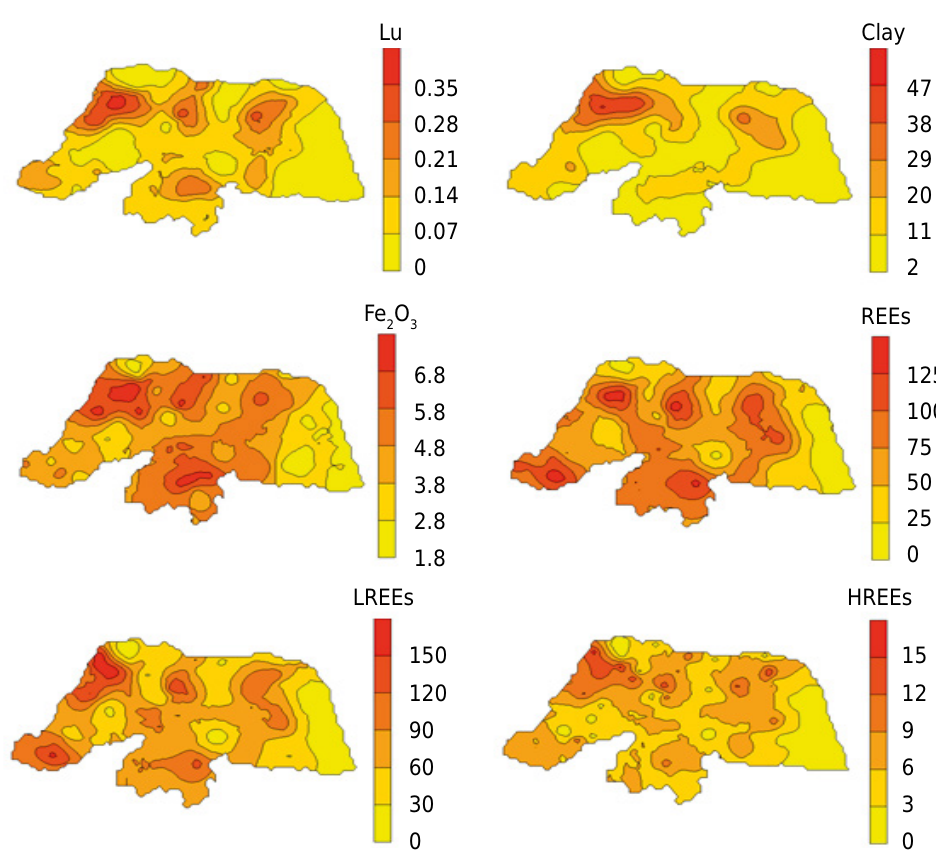
Figure 8. Spatial distribution of clay (%), Fe 2 O 3 (%), lutetium, REEs, LREEs, and HREEs in mg kg -1